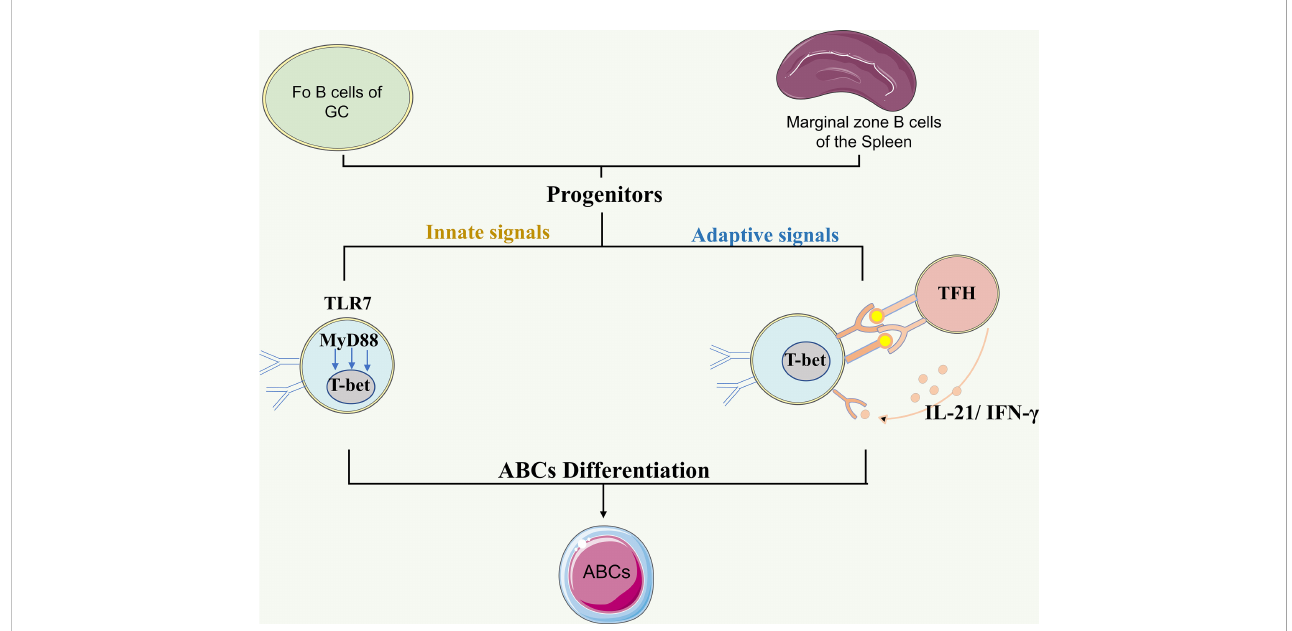
FIGURE 1 The origin and differentiation of ABCs. B cells from follicular and marginal zone of the spleen may serve as progenitors for ABCs. The differentiation of ABCs can be regulated by a combination of innate signals and adaptive signals. The innate signals TLR7 engagement followed by subsequent IFN g and/or IL-21 exposure in the context of Tfh cells is required for ABC differentiation. The Figure was partly generated using Servier Medical Art, provided by Servier, licensed under a Creative Commons Attribution 3.0 unported license. ABCs: Age/autoimmunity-associated B cells; GC: germinal center; TLR7: Toll-like receptor 7; TLR9: Toll-like receptor 9; IL-21: interleukin-21; IFN- g : interferon- g